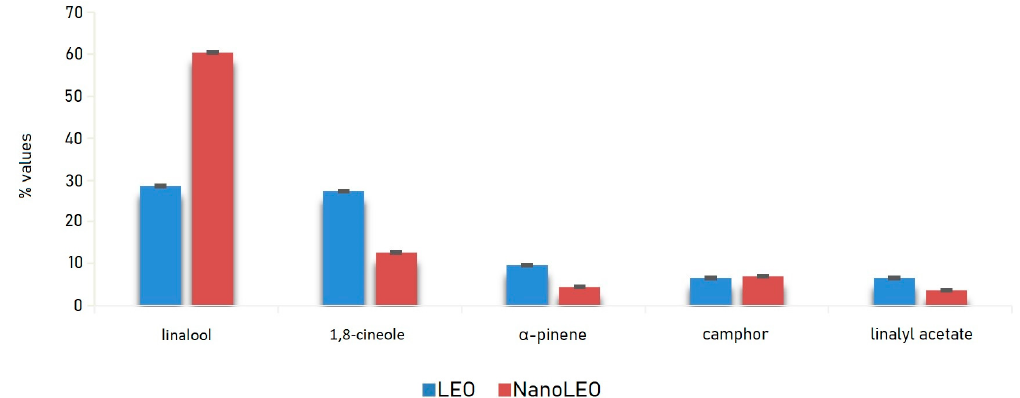
Figure 1. Bar graph of the values (%) of major compounds detected in lavandin essential oil (LEO) and nanoemulsion of lavandin essential oil (NanoLEO). p < 0.05 according to ANOVA test.